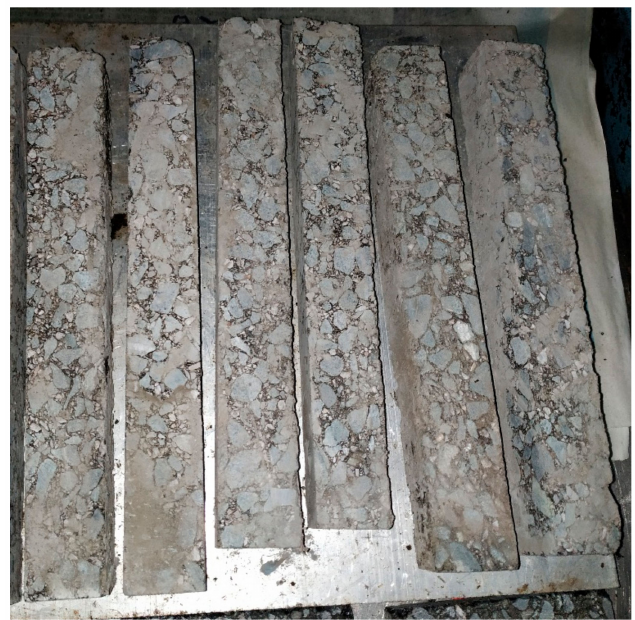
Figure 5. The beam specimens for the low-temperature bending test.